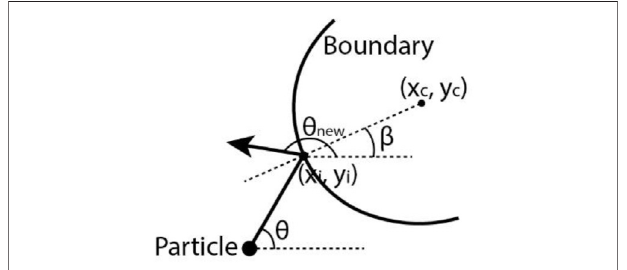
FIGURE3| Schematics oftheparticle changing moving direction from θ to θ new at the boundary.